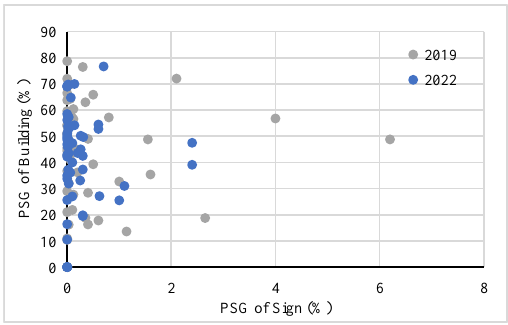
Figure 8. PSG of building-to-sign ratio in the historical areas.